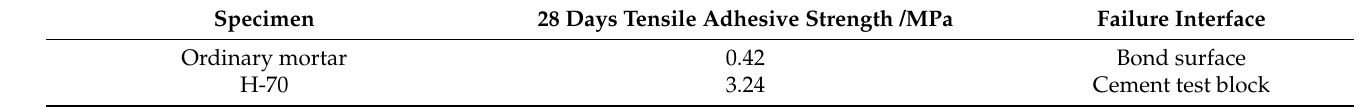
Table 2. Tensile adhesive strength.